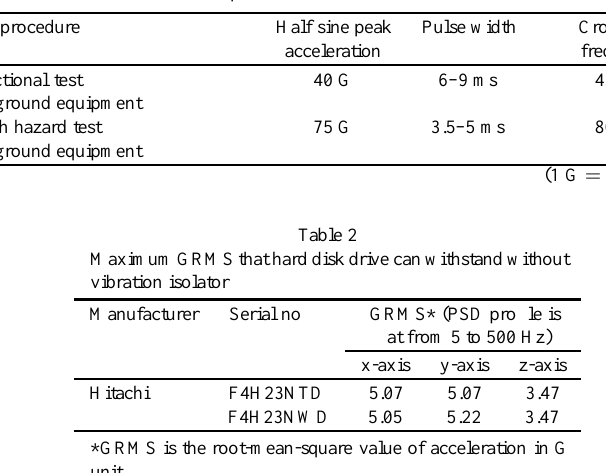
Table 1 Shock profile for functional shock test